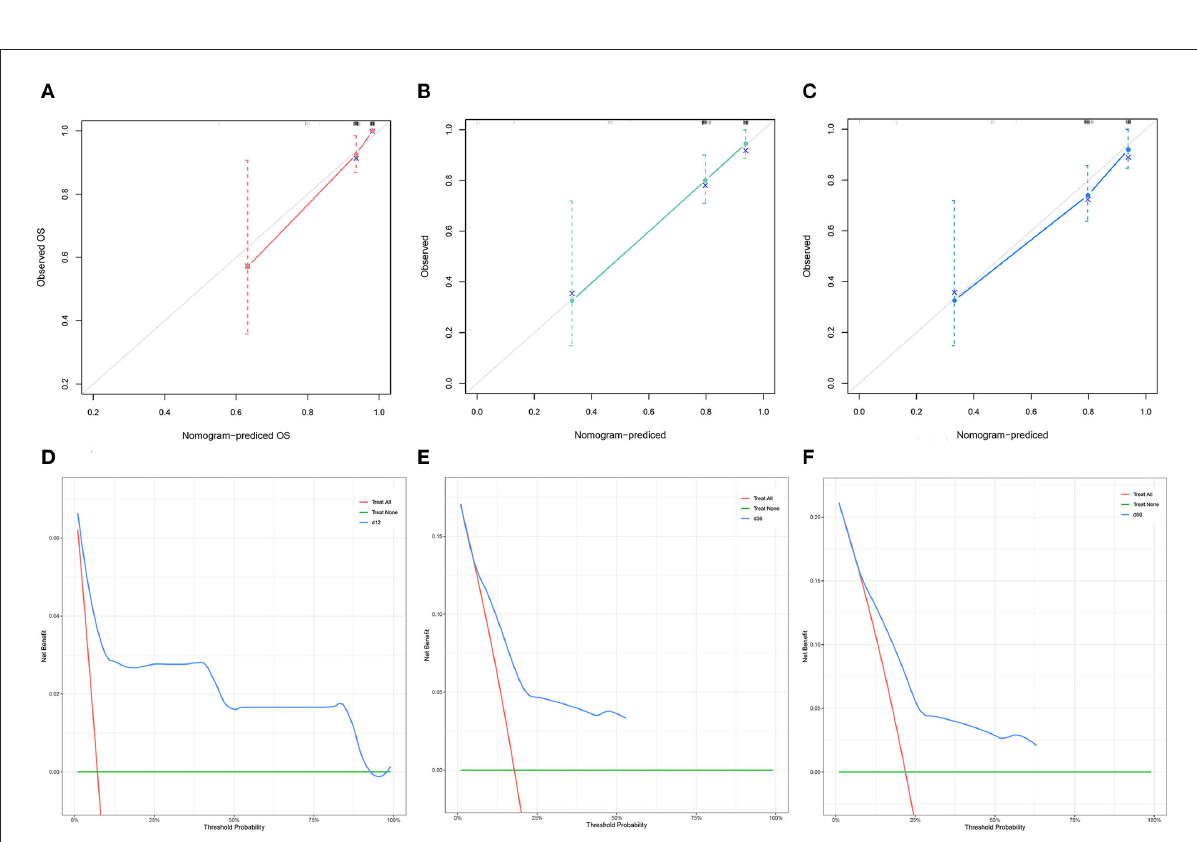
FIGURE4 The calibration curves of the nomogram for the 12 (A) , 36 (B) , and 60 (C) months in the training set. The decision curve analysis of the nomogram for the 12 (D) , 36 (E) , and 60 months (F) in the training